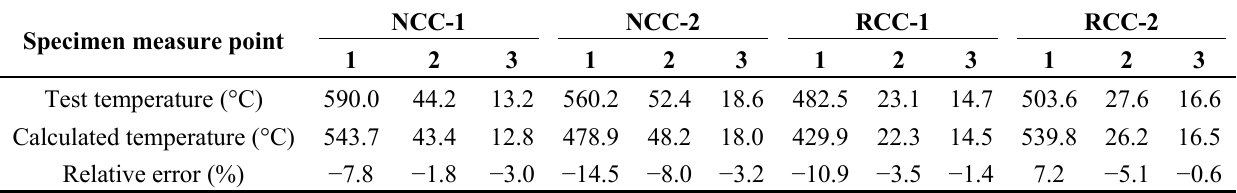
Table 7. Test and calculated temperature, as well as relative error at different measure points at 39